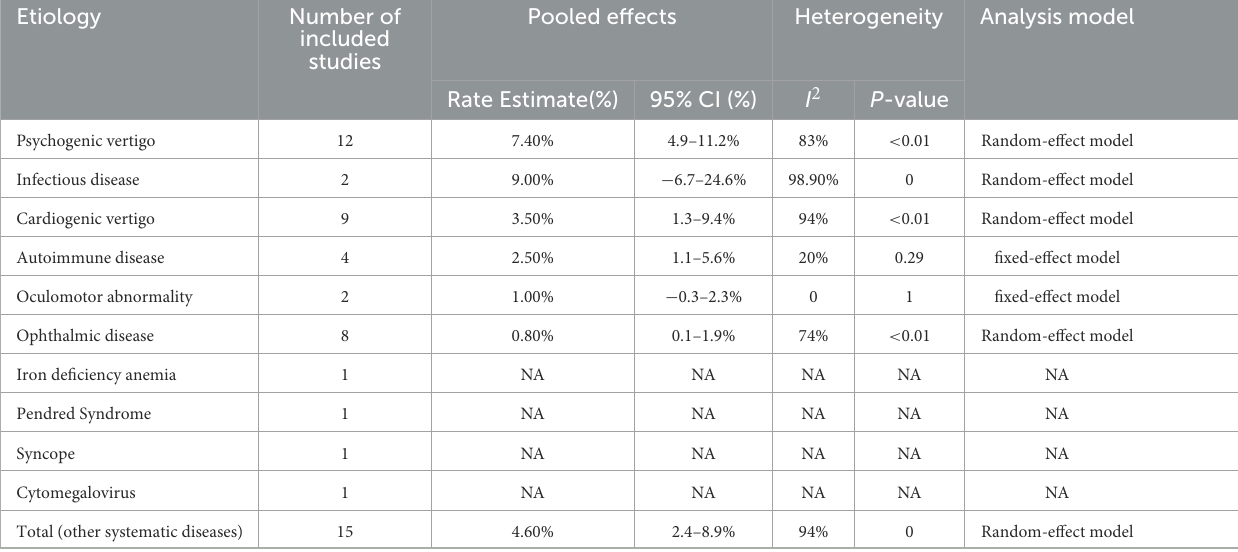
TABLE 5 Pooled analysis of each etiology for Psychogenic vertigo and other systematic disorders. Etiology Number of included